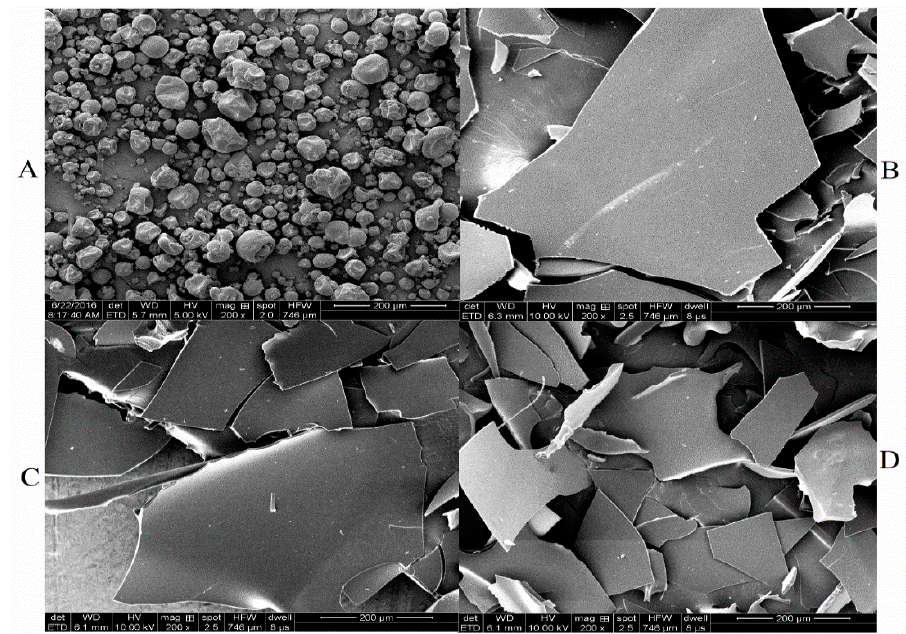
Figure 7. Scanning electron micrographs of SPI ( A : non-HIU treated SPI, B : 600 W-5 min HIU-treated SPI, C : 1000 W-25 min HIU-treated SPI, D : 1800 W-5 min HIU-treated SPI).